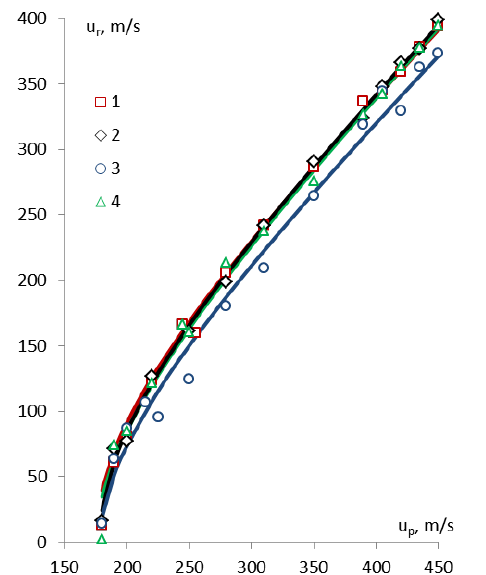
Fig. 8. Ballistic curves of perforation of heterogeneous barriers with the hard projectile.